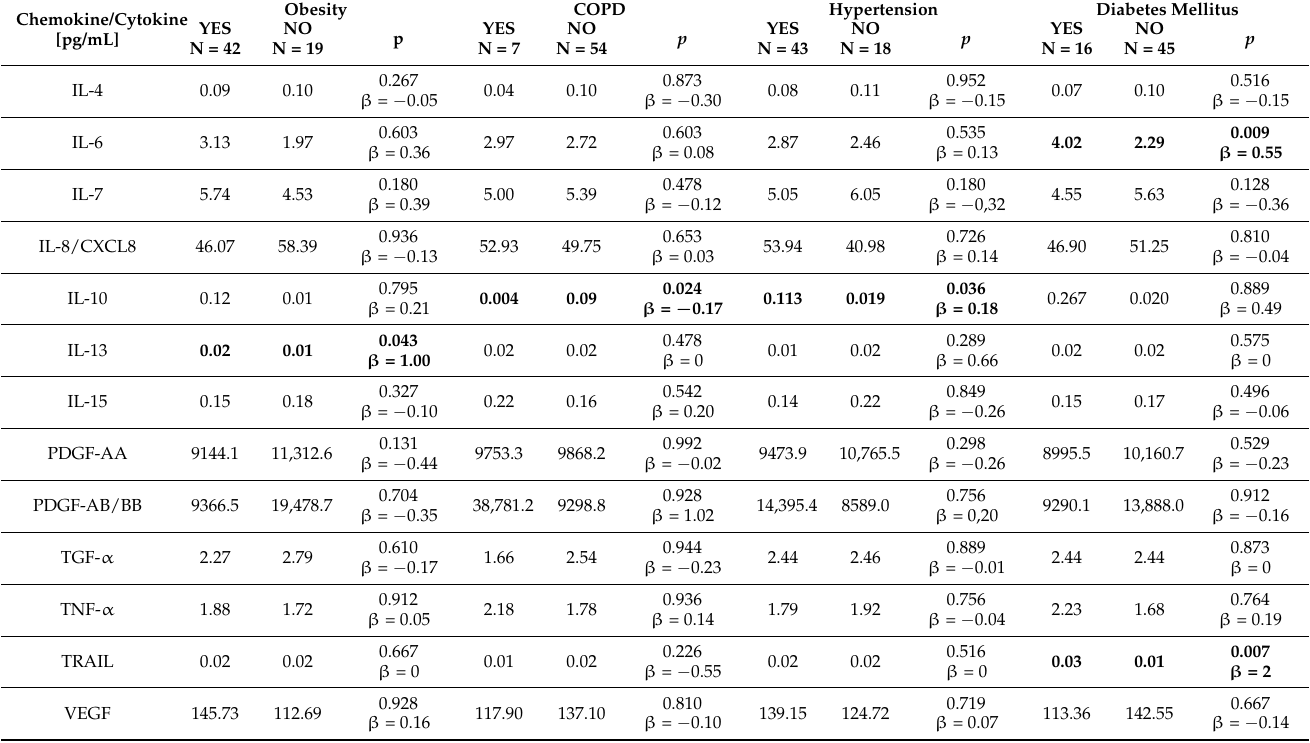
COPD—Chronic Obstructive Pulmonary Disease. The values are presented as mean across all OSA patients. Mann–Whitney U Test was used for calculations. β —standardized mean difference. Statistically significant results